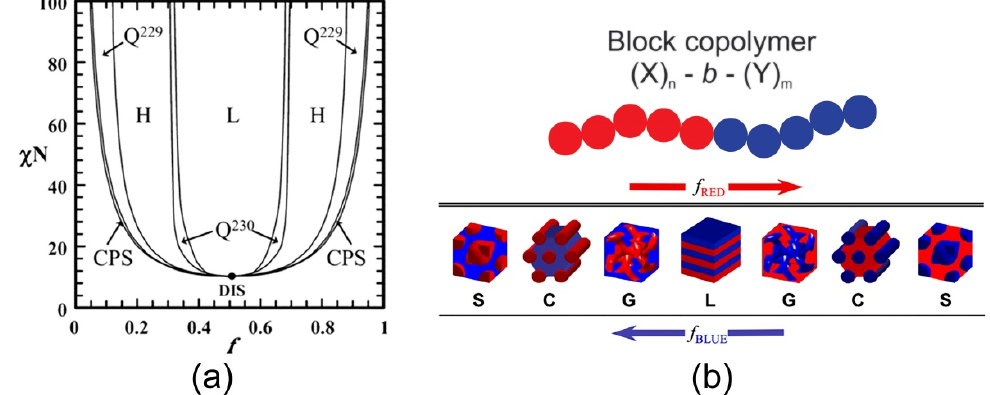
Figure 1. ( a ) Theoretical phase diagram of diblock copolymer melts calculated by using the SCFT and schematic representation of different morphologies. Reprinted with permission from reference [35] Copyright 2006 American Chemical Society. f , volume fraction of one block; χ , Flory–Huggins interaction parameter; N, degree of polymerization; L, lamellae; H, hexagonally packed cylinders; Q 230 , double-gyroid phase; Q 229 , body centered spheres; CPS, closed-packed spheres; and DIS, disordered. ( b ) Equilibrium-ordered state transitions in diblock copolymers determined by relative volume fraction f. Spherical (S), cylindrical (C), bicontinuous gyroidal (G), and lamellar (L)microdomain organization nanostructures of a linear AB diblock copolymers. Adapted with permission from reference [36].